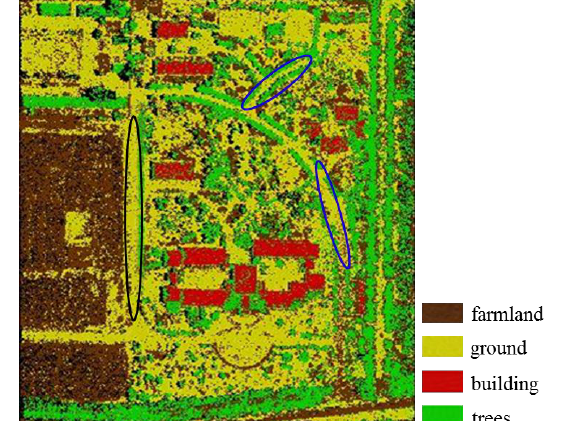
Figure 5. Land cover classification results of Miyun area based on SVM method Truth C Classification